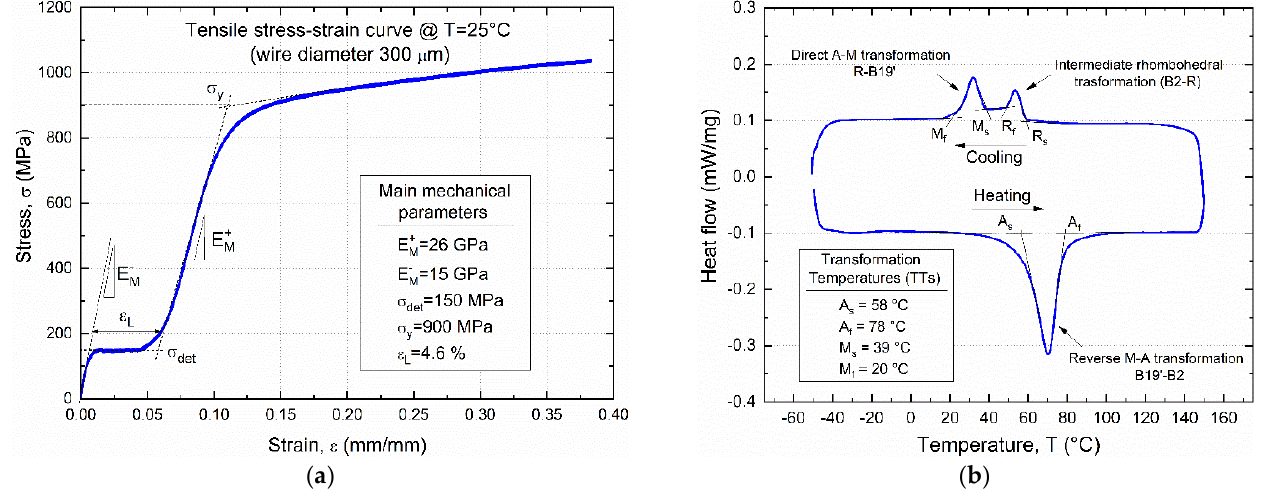
Figure 2. Thermomechanical properties of the selected SMA: ( a ) isothermal (T = 25 ◦ C) stress–strain curve with main mechanical parameters; ( b ) differential scanning calorimetry thermogram with measured transformation temperatures